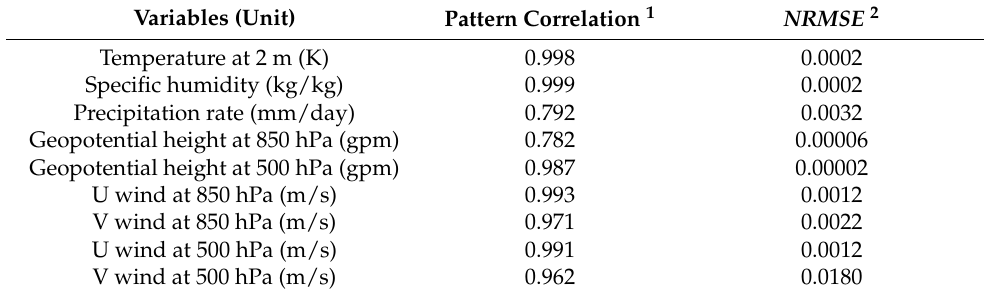
Table 3. Evaluation of the simulated meteorological fields (average fields from June to August